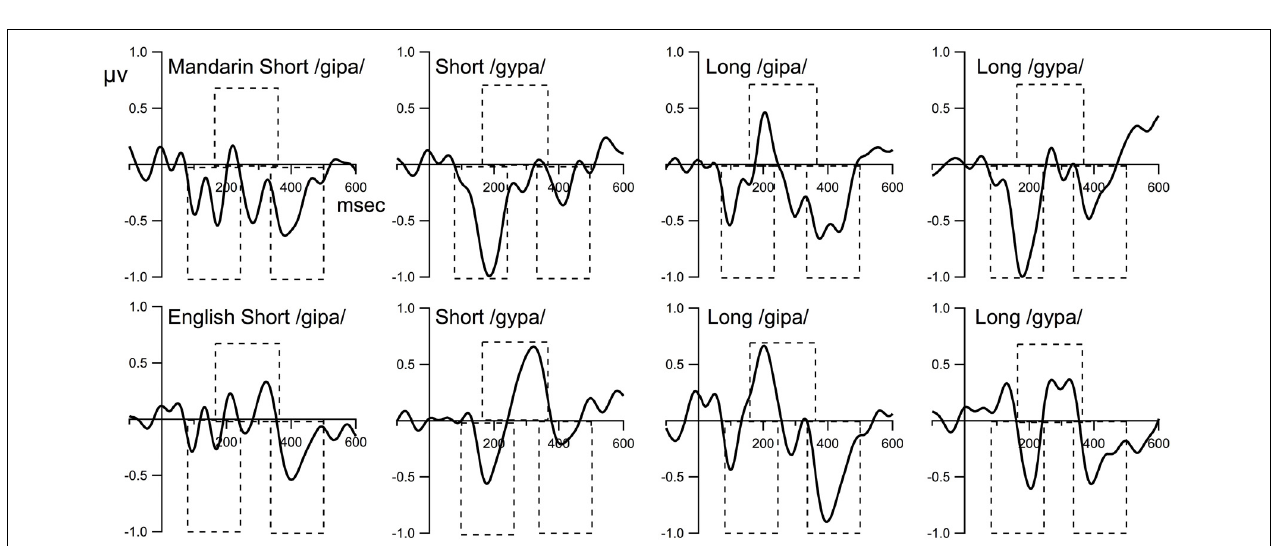
FIGURE 3 | The difference waveforms (deviant minus standard). The time windows for MMN, P3a, and LN are 80–240 ms, 160–360 ms, and 340–500 ms, respectively. Dashed boxes indicate time window used for statistical analysis.